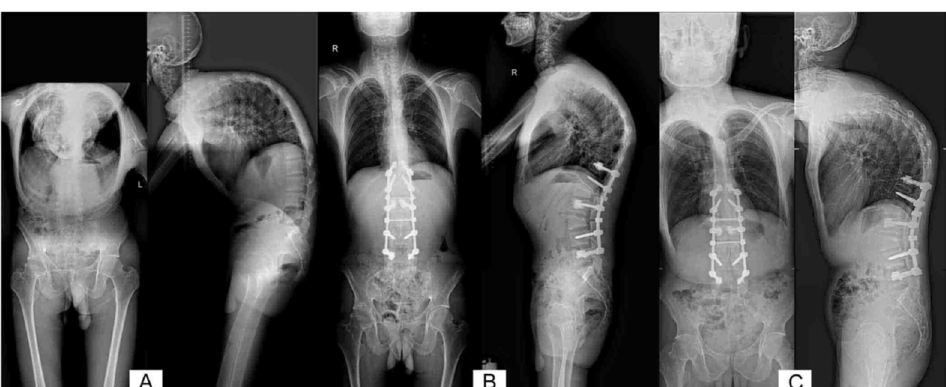
Figure 2 - X-ray images. (A) before surgery; (B) immediately after surgery; and (C) at the final follow-up at 52 months in a 31-year- old man with a 4-year history of lower back pain and progressive kyphosis. AS and kyphosis with severe osteoporosis were diagnosed (T-score=–3.0). The patient underwent a partial osteotomy of the key vertebrae without intervertebral fusion. PMMA-augmented CICPSs were used at the ends of the internal fixation instrument, and good spinal correction was obtained.